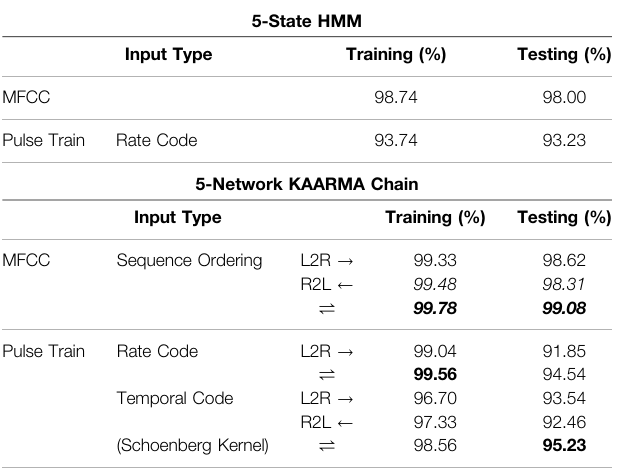
TABLE 3 | Comparisons of KAARMA chain classi fi ers with HMMs using an equivalent number of states and a mixture of eight Gaussians per state. Only 12 MFCC coef fi cients were used, without log energy and time derivatives. Similarly, only 12 channels of pulse trains were used.